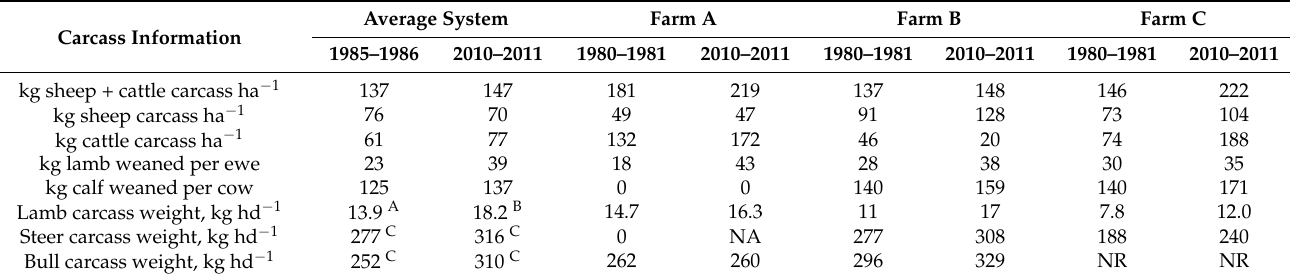
Table 5. Changes in annual carcass production on the Average System and case-study farms between the 1980s and 2010–2011. Lambing and calving percentages are presented in Tables 1 and